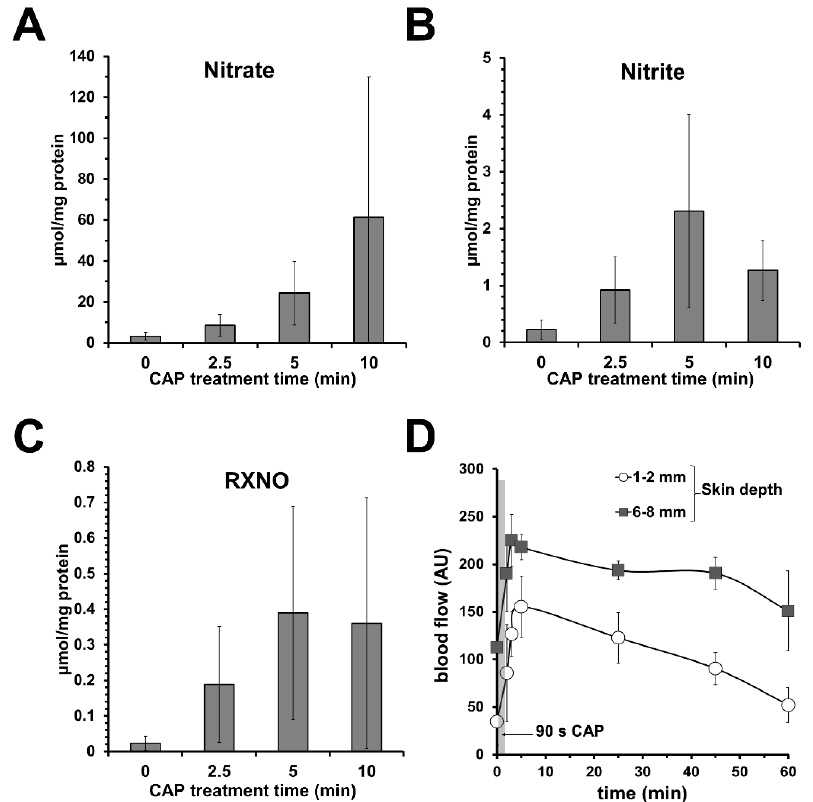
Figure 3. Topical application of cold atmospheric plasma (CAP) increases dermal microcirculation and the amount of nitric oxide derivates (NODs) in skin. Using a dielectric barrier device as CAP source, topical CAP treatment of human skin samples led to an increase in ( A ) nitrate, ( B ) nitrite, and ( C ) nitrosylated compounds (RXNOs) found in the respective skin homogenizates. Shown are the mean values ± SD of 6 independent experiments (treated skin surface 0.64 cm 2 ). ( D ) Hairless areas of forearm were treated with CAP (90 s) and blood flow was measured in different skin depths as indicated by a microlight guide spectrophotometer (O2C) device. Given are blood flow mean values ± SD of volunteers ( n = 4) showing a CAP-induced increase in dermal blood flow in the treated area.